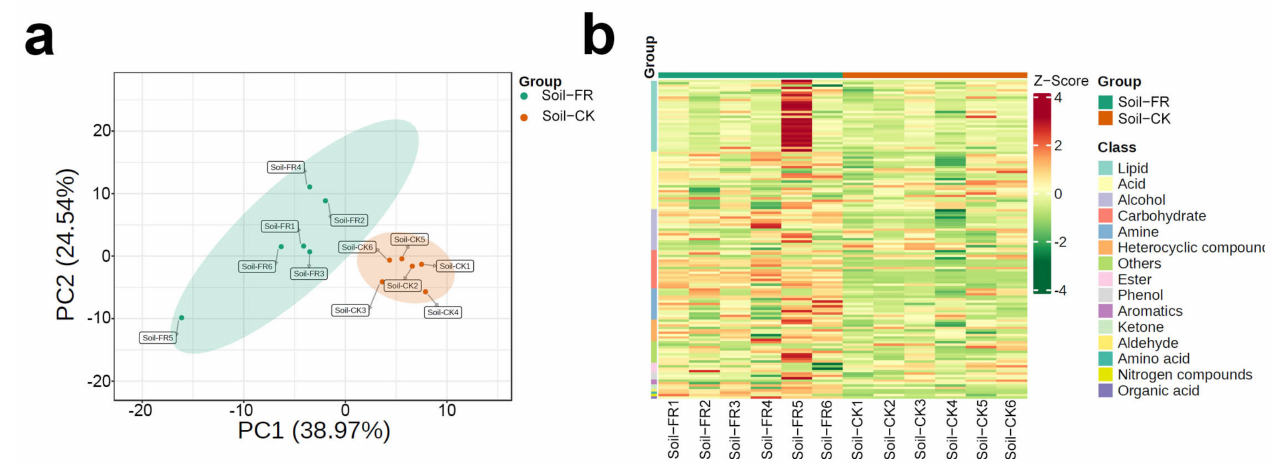
Figure 2. Distribution of soil metabolites in the FR and CK zones of the fairy ring ecosystem. ( a ) Principal component analysis (PCA) score plots of soil metabolome. PC1 represents the first principal component, and PC2 represents the second principal component. Percentage values indicate the proportion of variance explained. ( b ) Heat map clustering of the soil metabolites. Sample names are presented along the horizontal axis, and metabolite classes are written vertically; different colors on the map indicate the relative content of the metabolite (red represents high content, green represents low